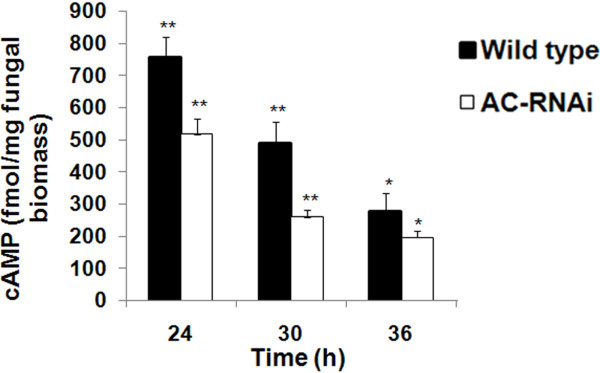
cAMP levels in the AC-RNAi mutant and wild type strains. Freshly harvested conidia (107 cells per mL) of AC-RNAi mutant and wild types were cultured in PD liquid culture, and harvested at 24, 30 and 36 h for estimation of the cAMP levels. Standard deviation bars denote averages from three independent experiments. *: significant difference, p <0.05; **: significant difference, p <0.01.